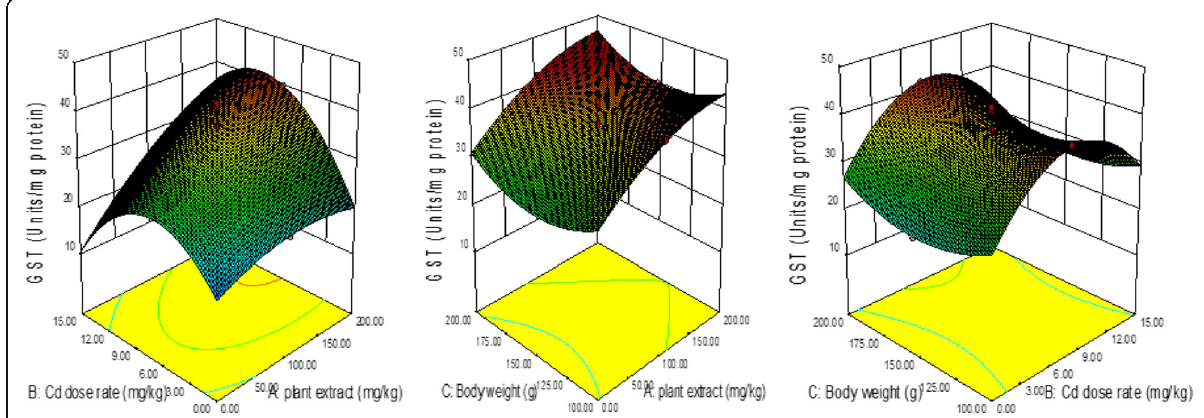
Fig. 6 3-D surface plots for serum GST activity under the influence of process